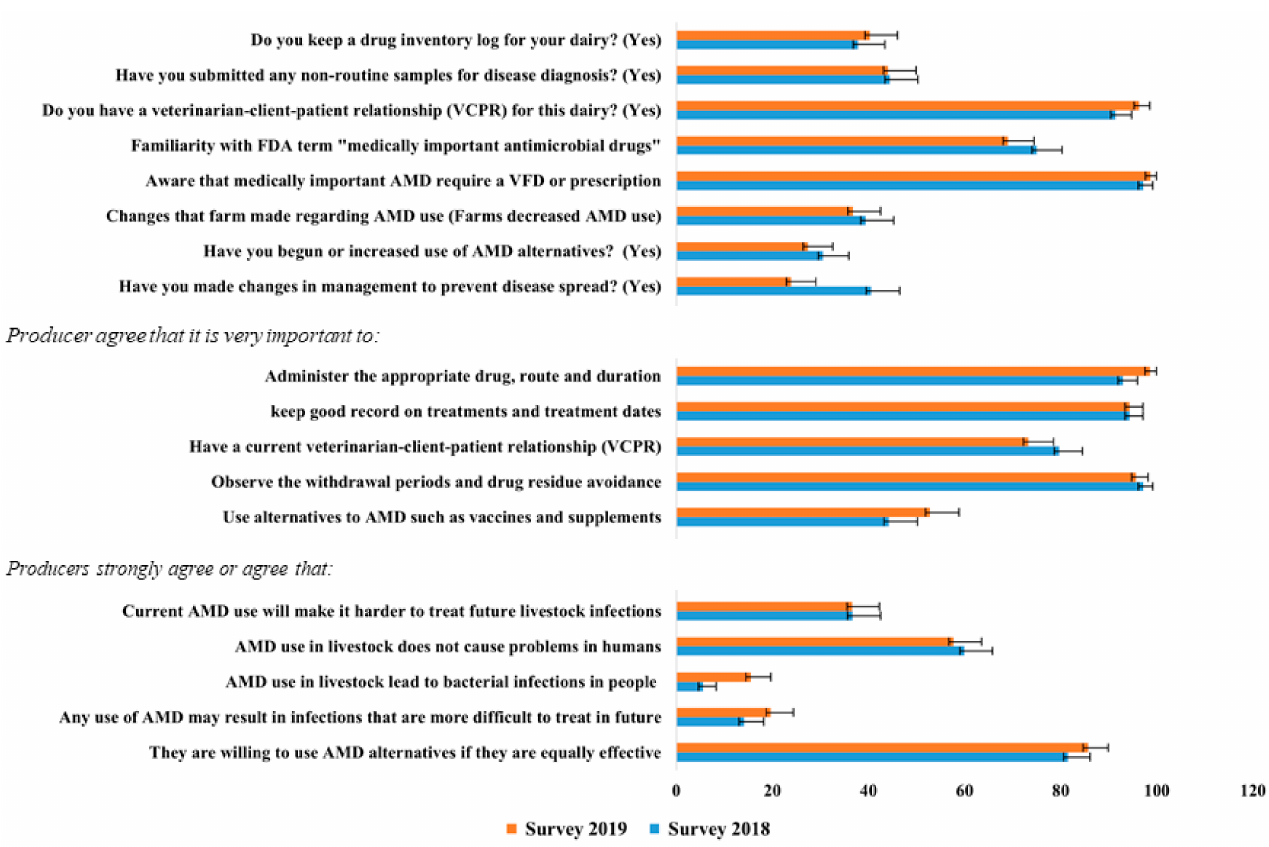
Figure 7. Responses of California dairy producers ( n = 75) to two surveys conducted in 2018 and 2019 on antimicrobial drug (AMD) use and stewardship practices in adult